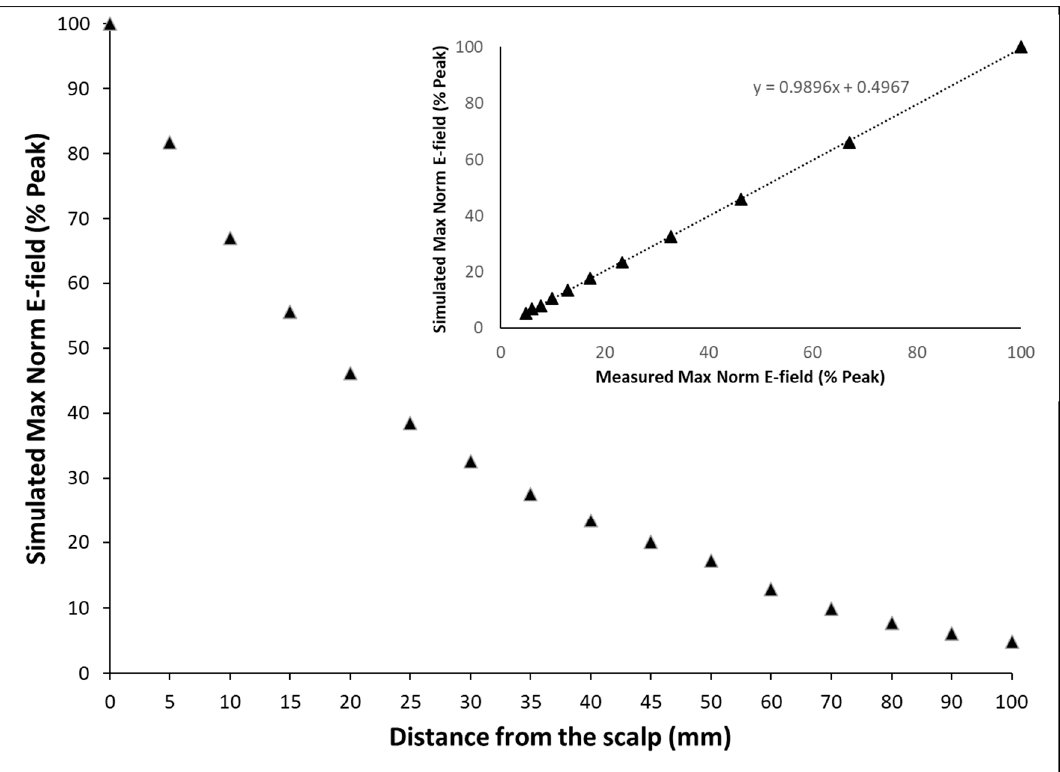
Figure 1. Decay of induced E-field over distance as modeled by SimNIBS. The simulated max norm E-field is expressed as a percent of maximum norm E-field at a certain distance away from scalp to that at the scalp surface. The E-field decays by the square of the distance of the coil from the scalp; inset: normalized E-field as modeled by SimNIBS vs. measured E-field expressed as % E-field at the surface of the coil. Measured max norm E-field is expressed as the ratio of the maximum norm E-field at a certain distance in air to that at the coil surface. The simulation shows excellent agreement with the measured data with a R 2 = 0.98.